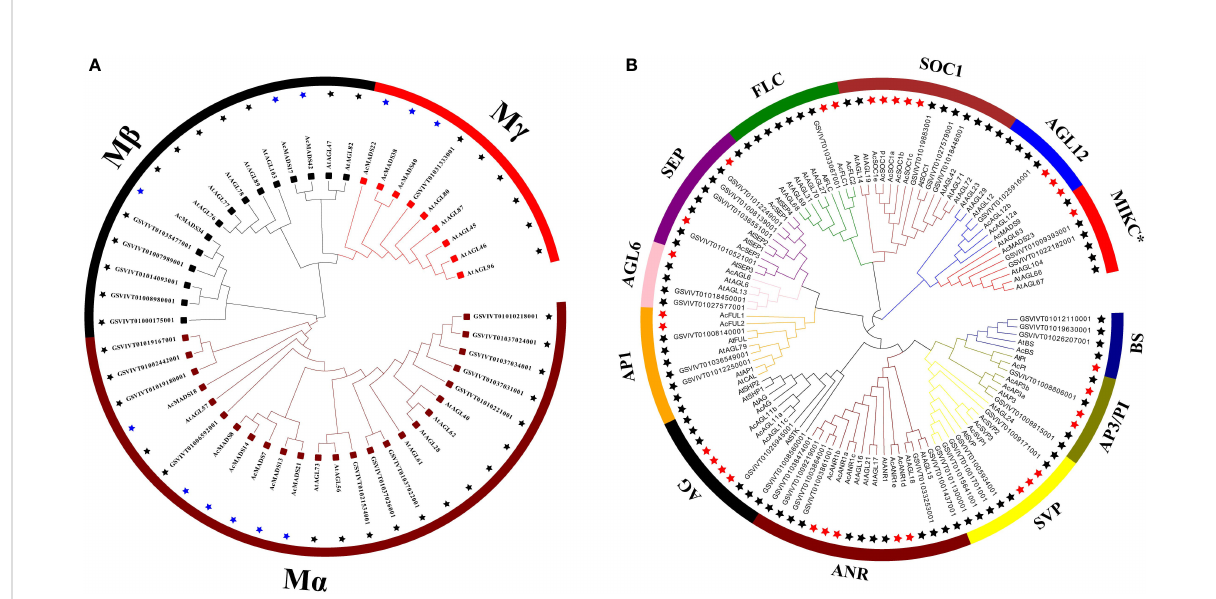
FIGURE 2 Phylogenetic analysis of type I (A) and type II (B) MADS-box genes in Arabidopsis , grape, and pineapple. The phylogenetic trees were constructed using the ML method. The black stars represent the MADS-box proteins from the grape and Arabidopsis , then the blue and red stars respectively represent the type I and type II MADS-box proteins from the pineapple. MADS-box proteins from the grape with the pre fi x “ GSVIVT ” indicate “ VvMADS ” and “ At ” means “ AtMADS ” in Arabidopsis